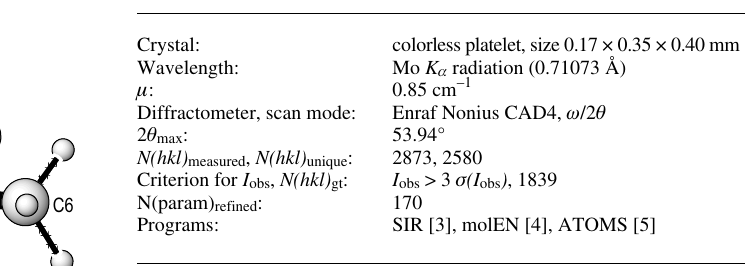
fairly with the displacements observed for 1,3,5-trimethyl-2,4- planeandthephenylringcalculatesas77.94(6)°.Inthecrystalstruc- ture the molecules are stacked in piles along [001], which in turn are arranged in a distorted hexagonal rod packing. Table 1. Data collection and handling.